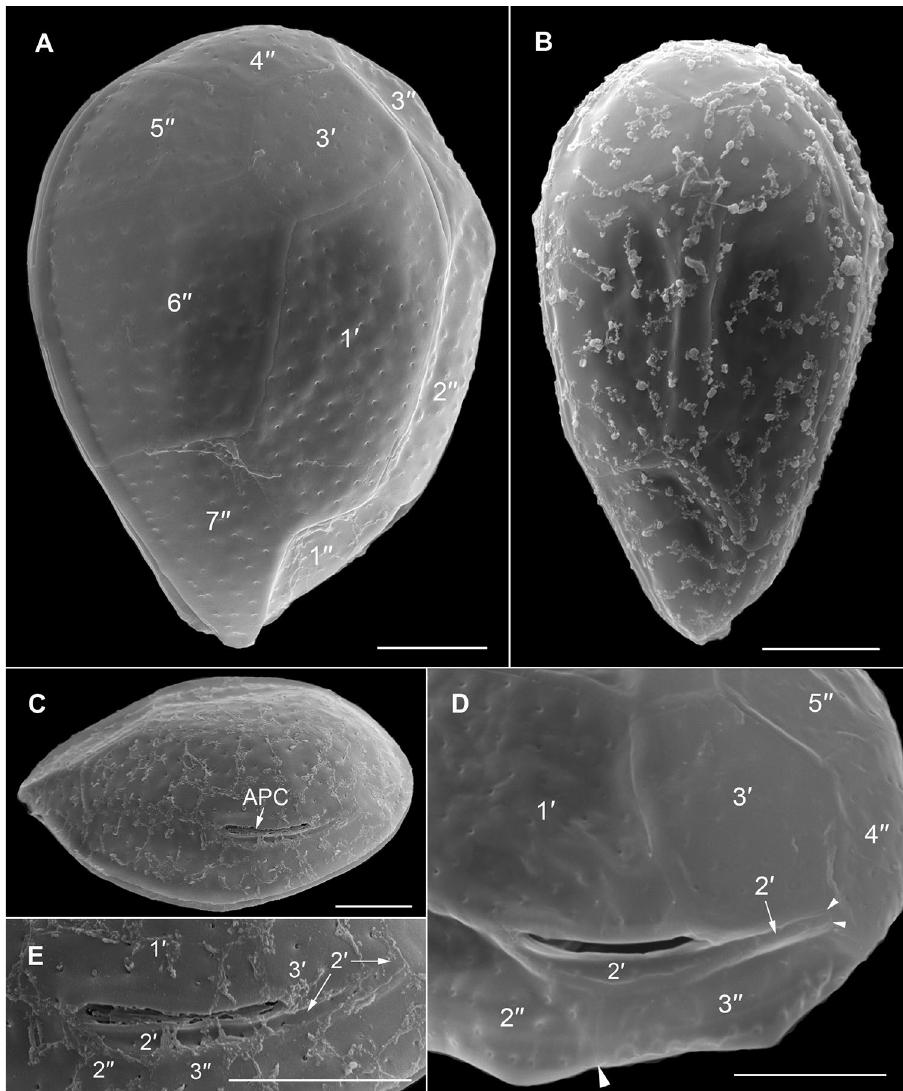
Figure 3. Scanning electron micrographs of Ostreopsis tairoto sp. nov. cells from field samples showing the epithecal tabulation. ( A,B ) Apical view of a wide ( A ) and narrow ( B ) cell. ( C ) Left lateral to apical view showing the apical pore complex (APC) in left dorsal position. ( D ) Detail of the left dorsal epitheca with the narrow and elongated second apical plate (2 ′ ) below the APC separating the third apical (3 ′ ) from the third precingular (3 ′′ ) plate and contacting the fourth precingular (4 ′′ ) plate. Note the dorsal end of the 2 ′ plate (small arrowheads) and the suture between plates 2 ′′ and 3 ′′ (large arrowhead). ( E ) Detail of the left elongated 2 ′ plate below the APC separating the 3 ′ from the 3 ′′ plate. Scale bars = 10